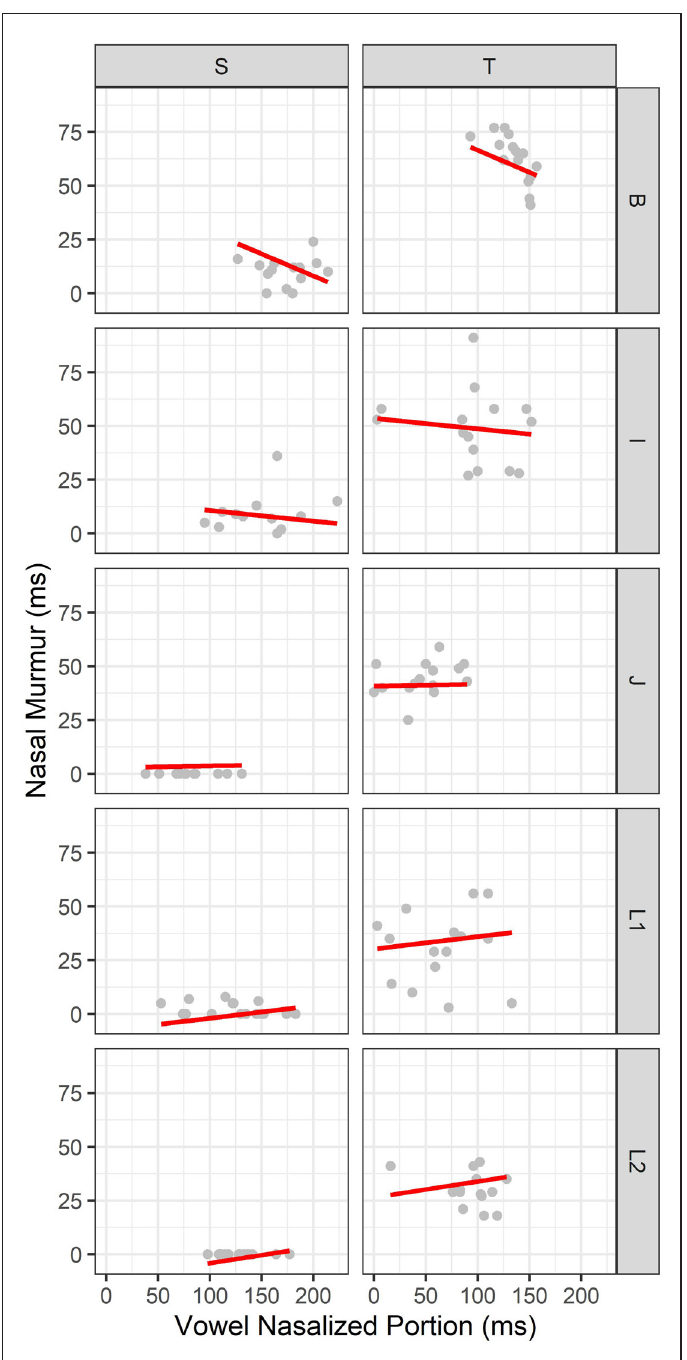
Figure 7: Duration of nasal murmur (ms) as a function of the duration of the nasalized portion of the vowel (ms) by